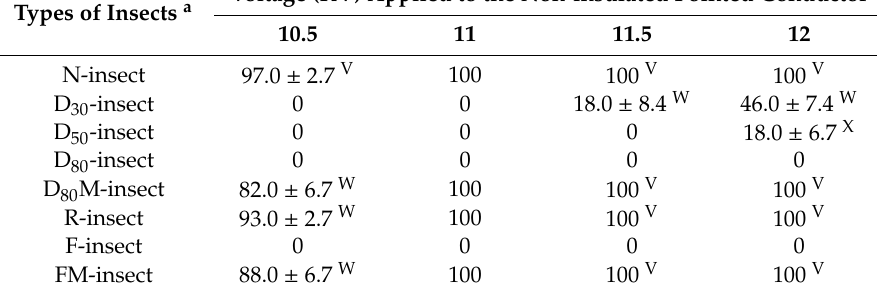
Table 3. Percentage of temperature-treated houseflies exposed to an arc discharge in the dynamic electric field producer